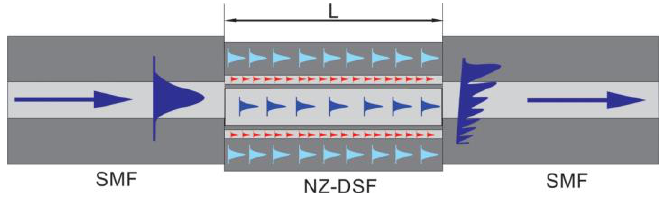
Figure 3. The Schematic diagram of Mach-Zehnder Interferometer.